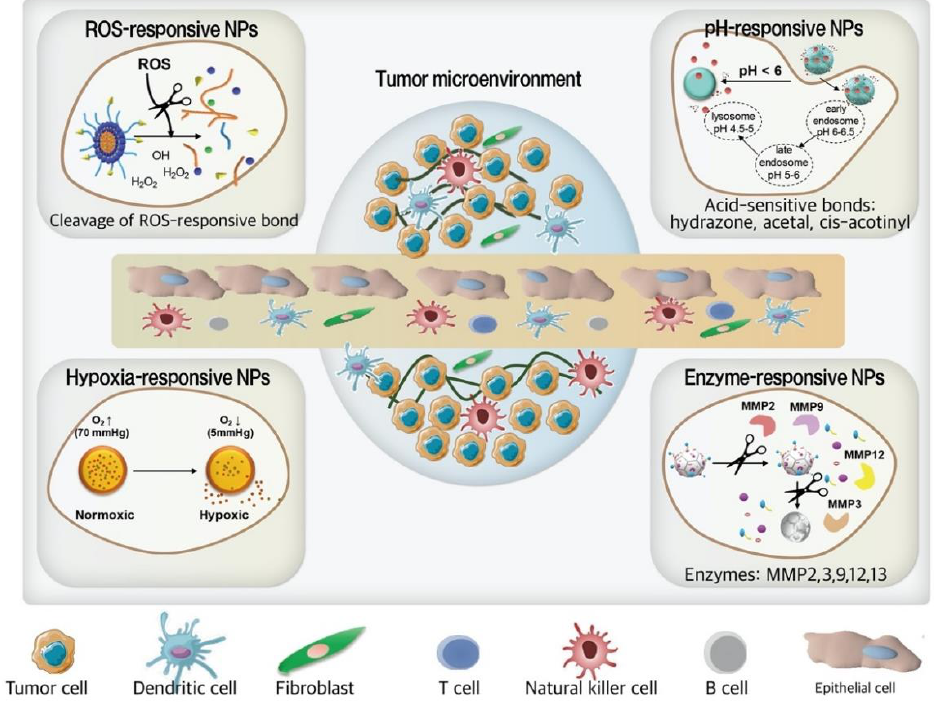
Figure 4. Schematic illustration of tumor microenvironment-responsive smart NPs including pH, ROS, hypoxia, and enzyme-responsive NPs for treatment of TNBC. ROS-responsive and hypoxia activated NPs trigger the drug release in enhanced ROS formation or reduced oxygen in cancer cells. In pH-responsive NPs, acid-sensitive bonds in low pH of TNBC environments are cleaved. Some enzyme-sensitive bonds are easily cleaved by overexpressed enzymes such as MMP in the tumor microenvironment.